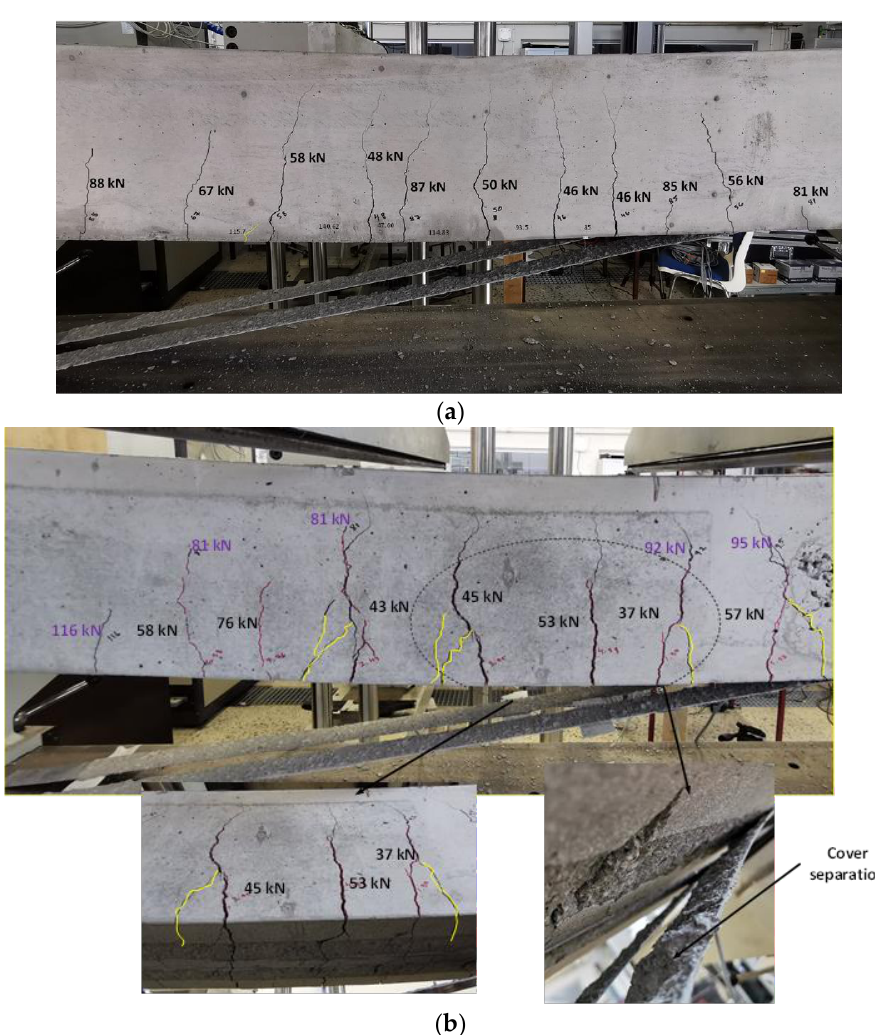
Figure 8. ( a ) B.0 beam (0% of Py). ( b ) A.70 beam (70% of Py).